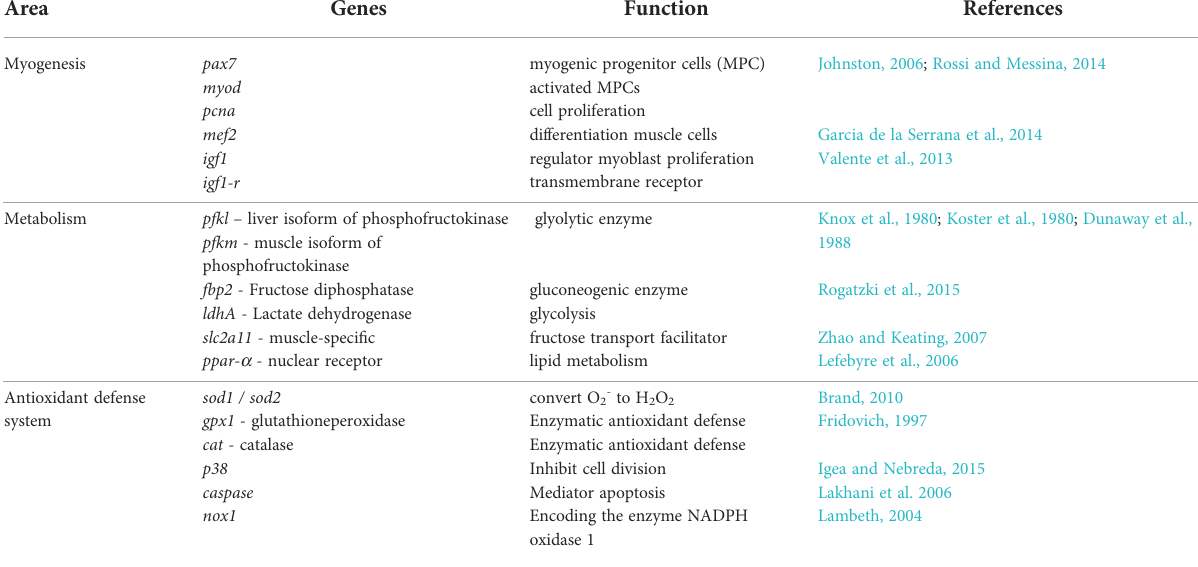
TABLE 1 Target genes and receptors selected for evaluation of possible effects from live prey type in relation to myogenesis, glycolysis, gluconeogenesis and oxidative phosphorylation in cod larvae.